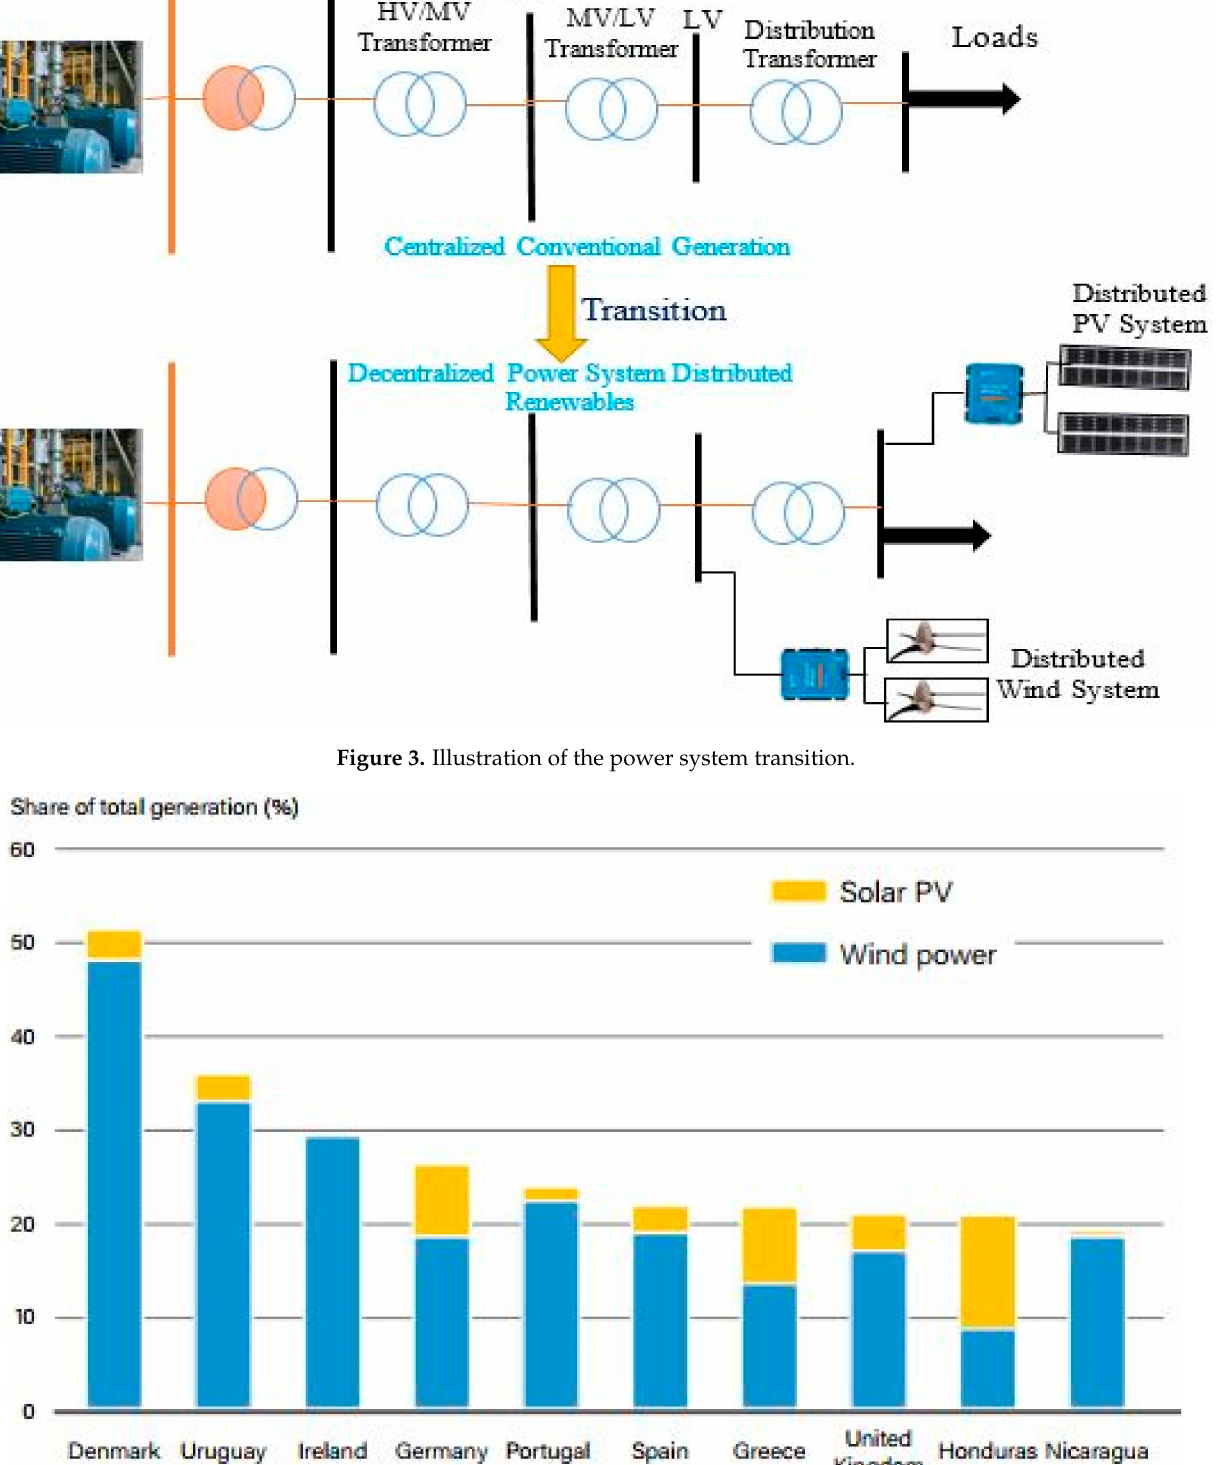
Figure 4. Solar and wind electricity generation mix from the top 10 countries in 2018